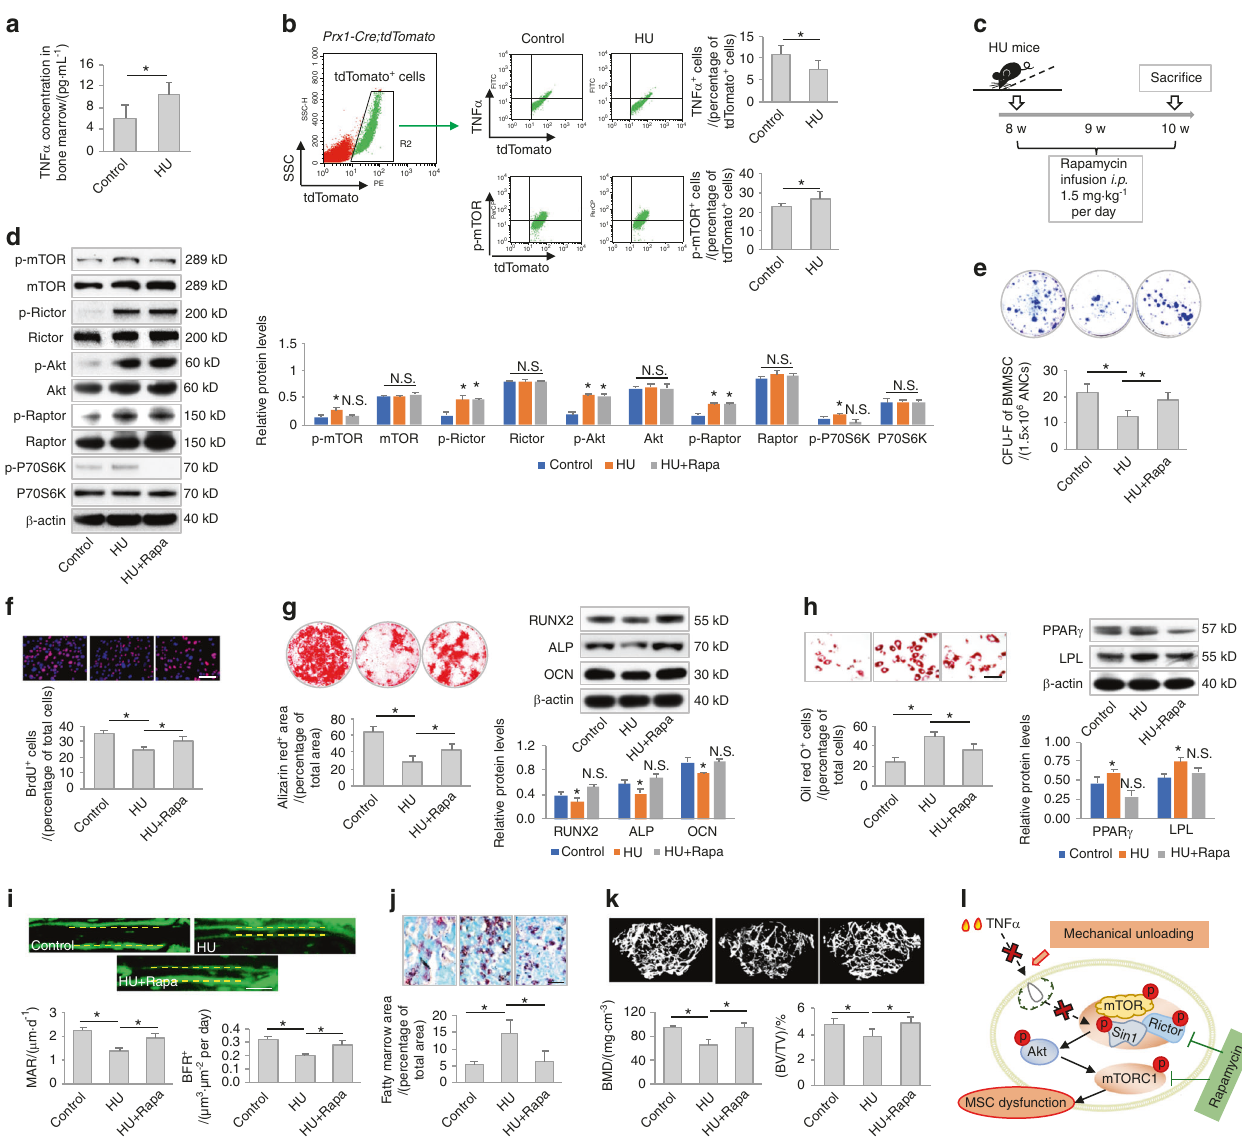
Fig. 6 Mechanical unloading induces MSC functional decline and bone loss that are counteracted by rapamycin. a ELISA analysis of TNF α levels in the bone marrow of control and hindlimb unloading (HU) mice ( N = 5). b Flow cytometric analyses of TNF α + cells and p-mTOR + cells in bone marrow mesenchymal cells. Prx1-cre:tdTomato mice ( N = 5) were used to label bone marrow mesenchymal cells in vivo. c Schematic diagram showing the experimental design used to investigate the effect of rapamycin treatment on HU mice in vivo. d Western blot analyses of mTOR signaling ( N = 3). e – h Functional analyses of MSCs according to CFU, BrdU labeling, and osteogenic and adipogenic differentiation. N = 5. Scale bars = 100 μ m. i Calcein labeling for bone formation analysis. N = 5. Scale bar = 50 μ m. j Oli red O staining for bone marrow adiposity. N = 5. Scale bar = 150 μ m. k Micro-CT analysis of trabecular bone mass ( N = 5). l Diagram showing mechanical unloading-induced MSC functional decline and bone loss counteracted by rapamycin. For quanti fi cation of Western blotting, a two-tailed Student ’ s t test was used for the comparison between the treatment and control groups. * P < 0.05. Data represent the mean ±